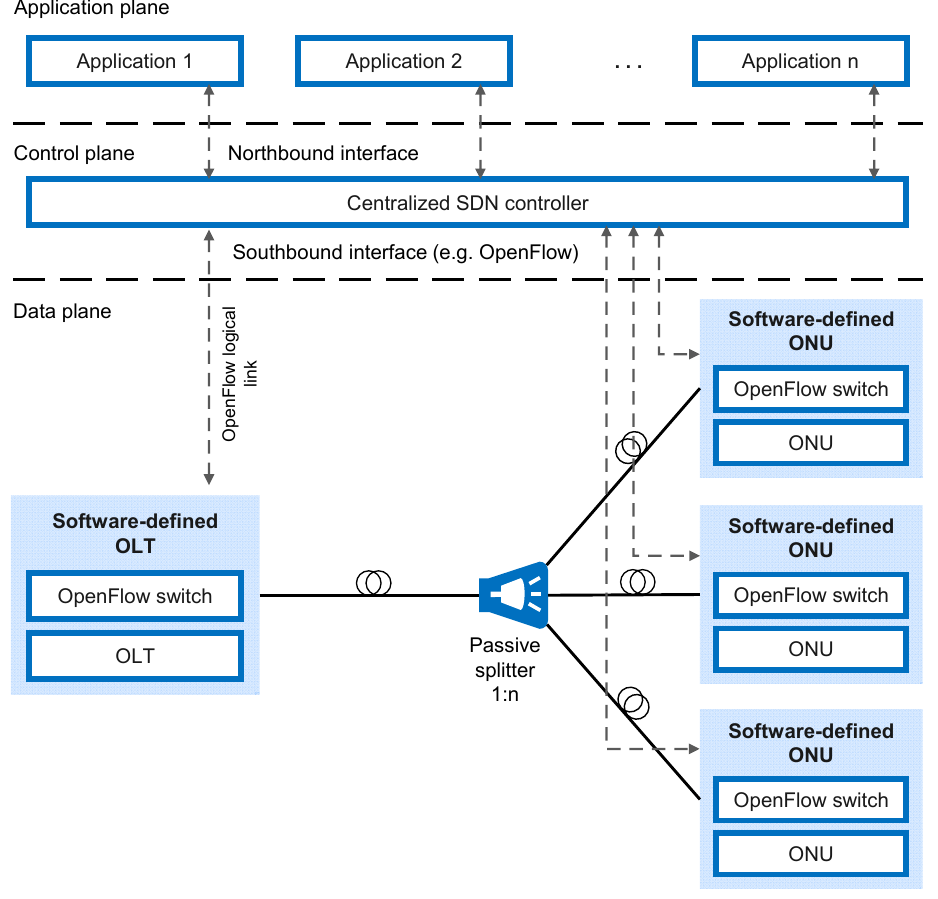
Figure 11. Software-defined PON architecture.